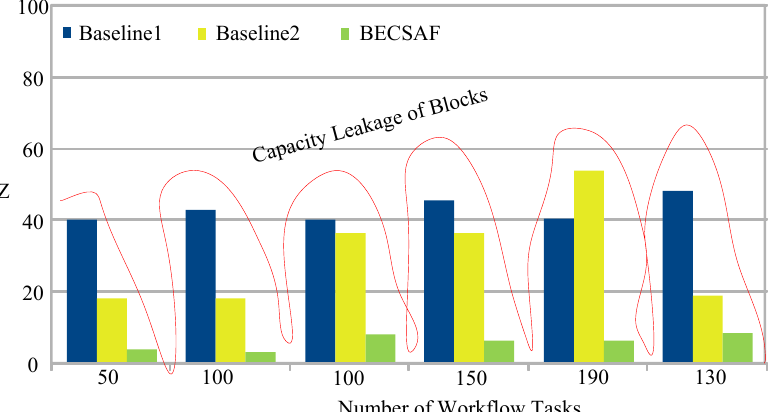
Figure 12. Resource Capacity Leakage of Blocks in